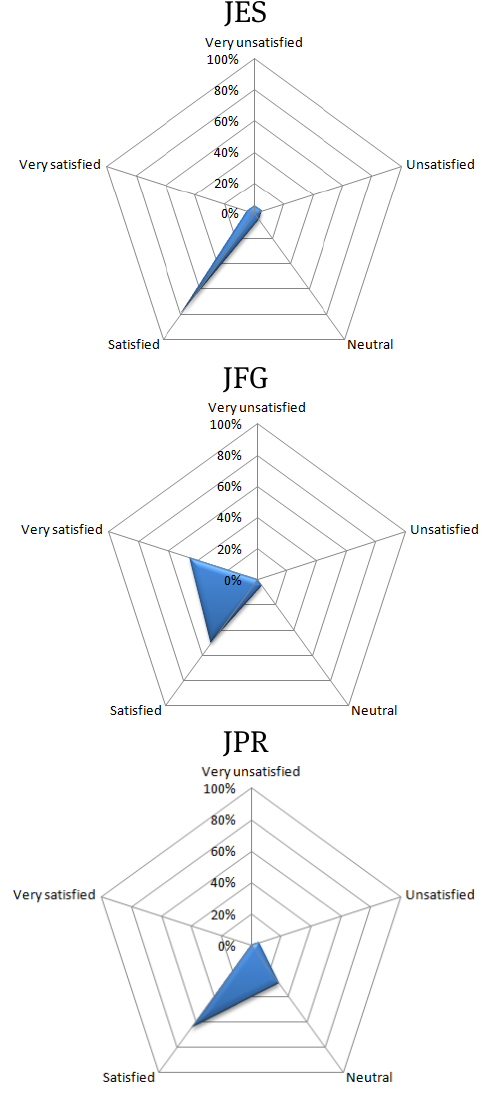
Figure 4: Evaluation of the sound environment of the Lisbon